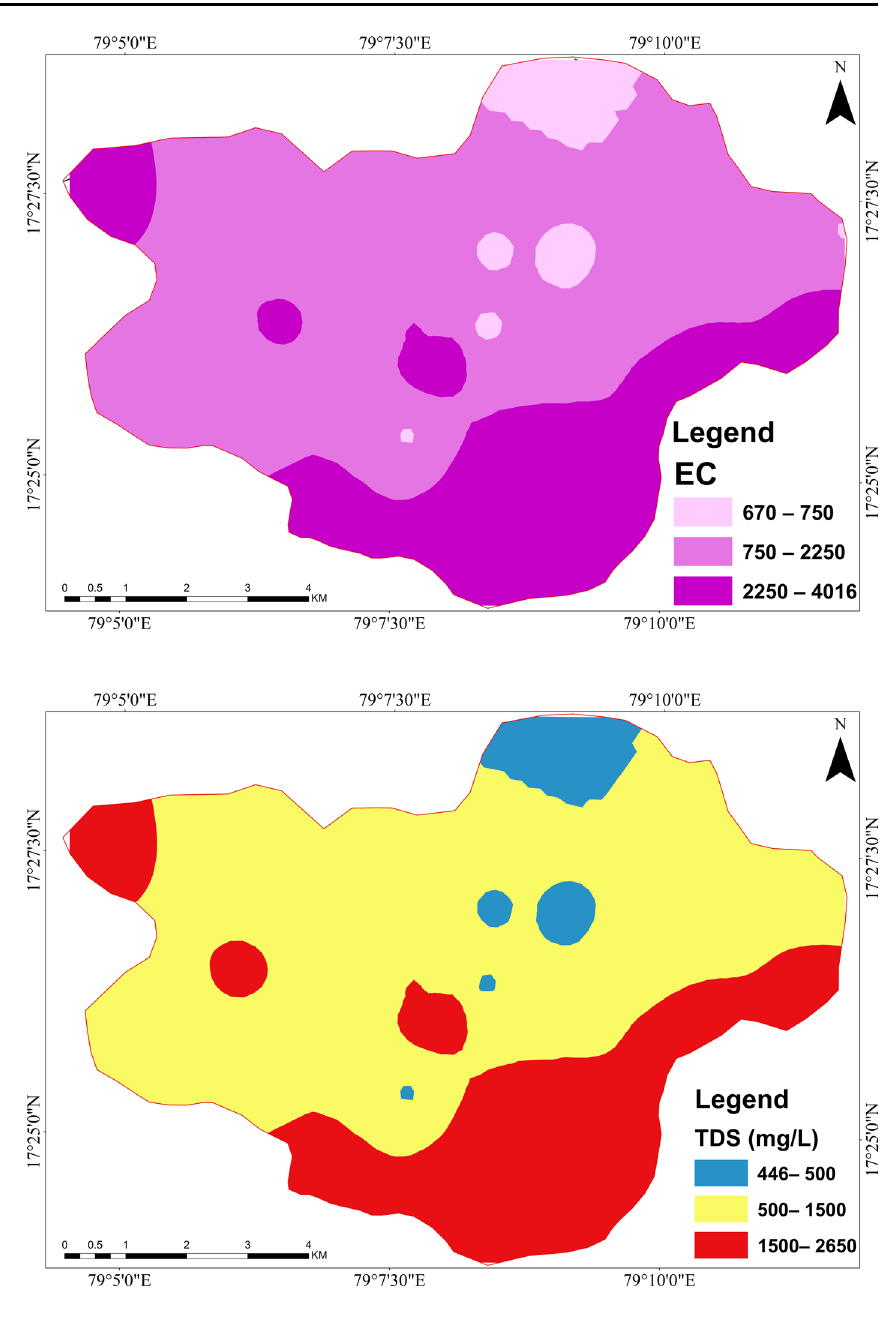
Fig. 3 Spatial distribution map of EC (µS/cm) in Mothkur region, Telangana State, South